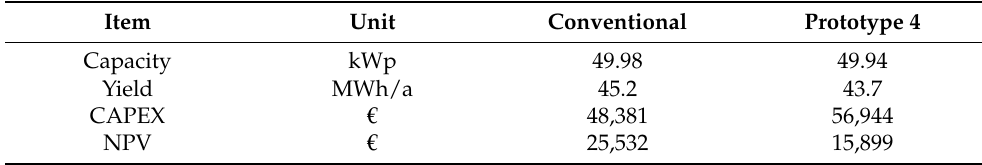
Table 10. Results of economic analysis for conventional and prototype (optimized prototype 4) PV